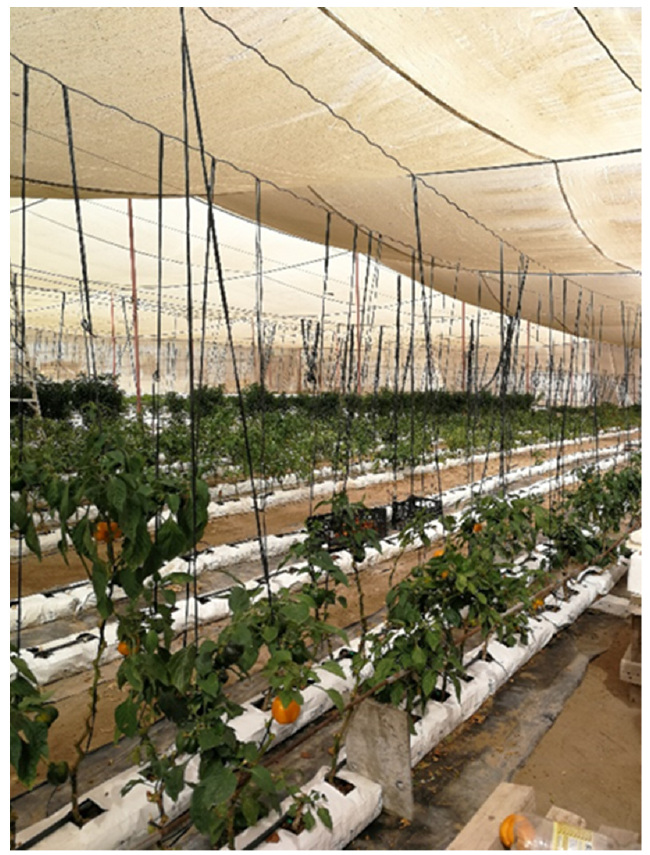
Figure 5. Hydroponic system of bell peppers, Alto la Portada, Antofagasta, Chile.